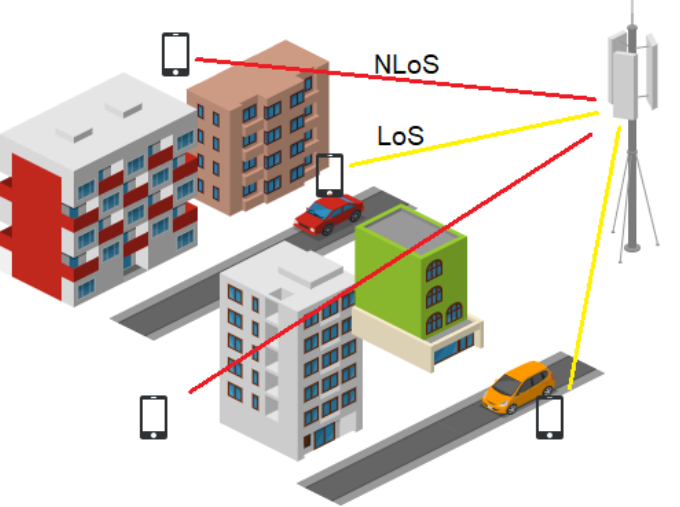
Figure 2. LoS and NLoS scenarios.